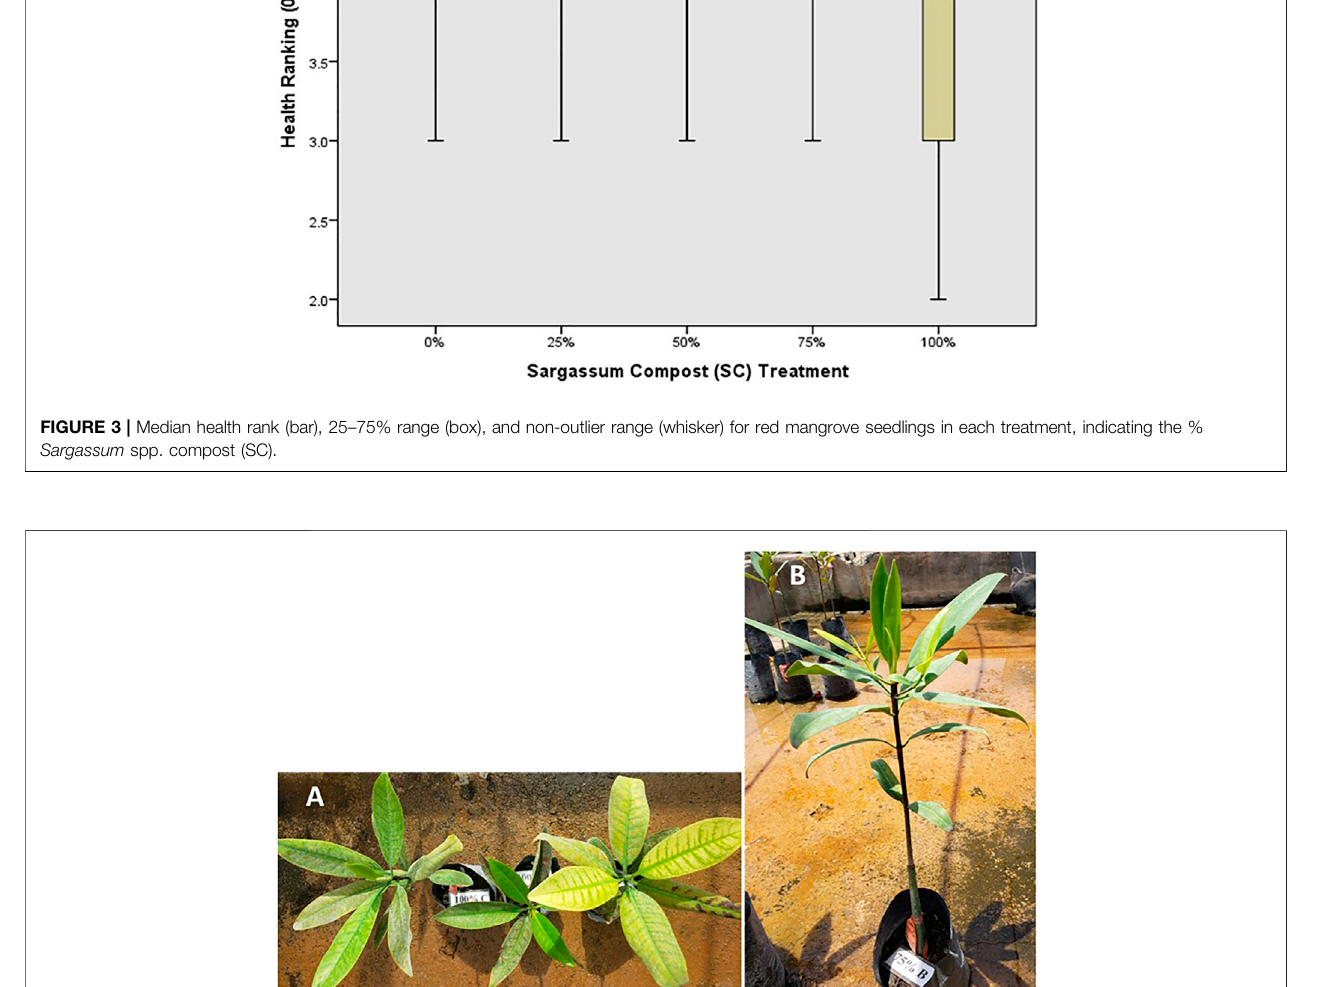
Frontiers in Environmental Science |